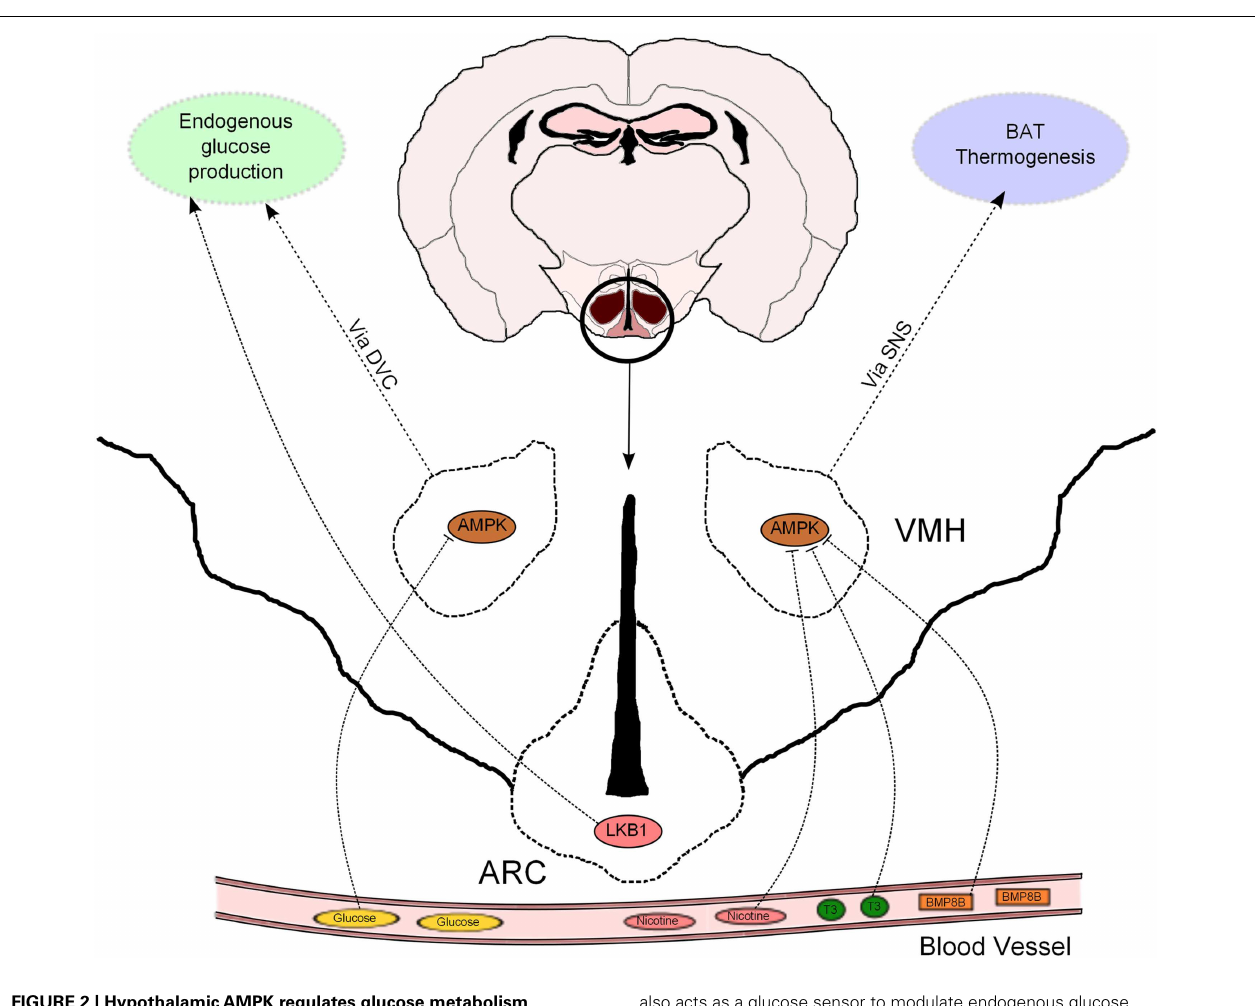
FIGURE 2 | HypothalamicAMPK regulates glucose metabolism and thermogenesis. Nicotine, triiodothyronine (T3), and bone morphogenetic protein 8B (BMP8B) exert their thermogenic properties on brown adipose tissue (BAT) through inhibition of AMPK in the ventromedial hypothalamus (VMH). AMPK in theVMH